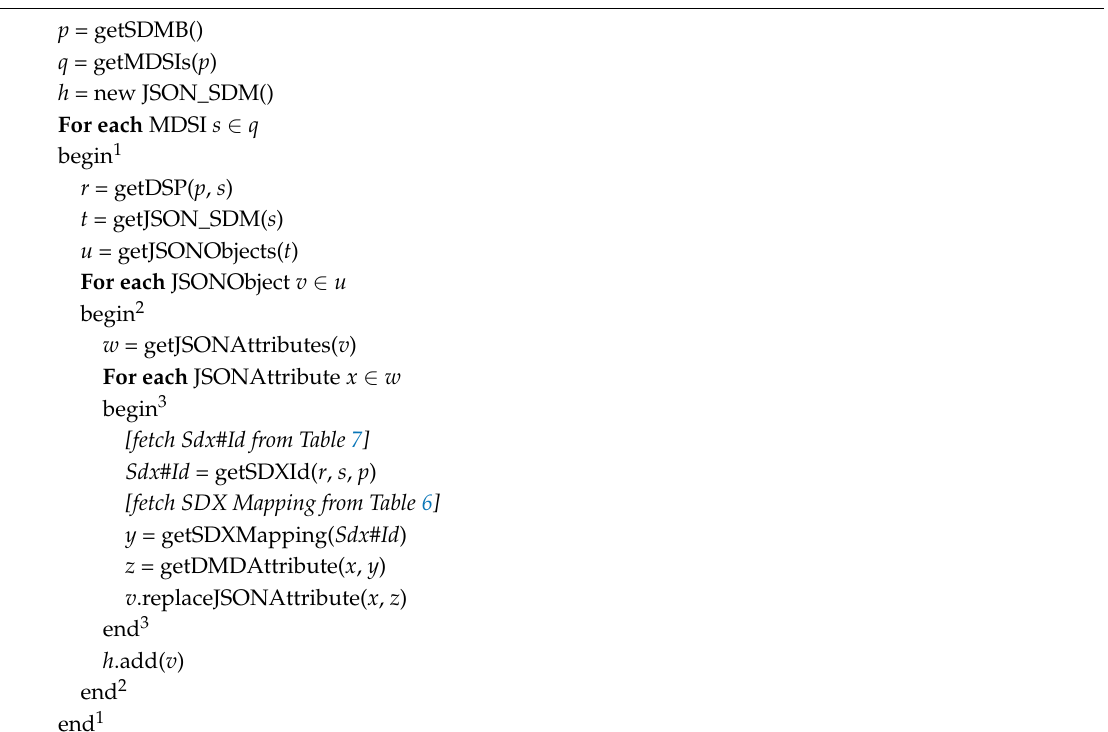
Algorithm 5. MSP’s Data Mashup Algorithm